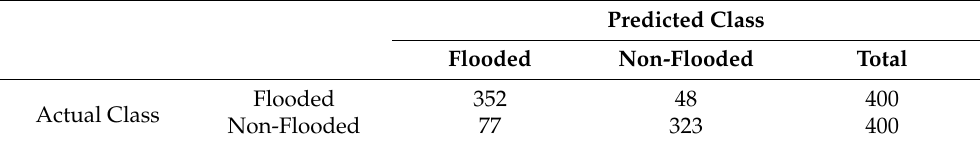
Table 3. Confusion matrix generated for a model trained using an original